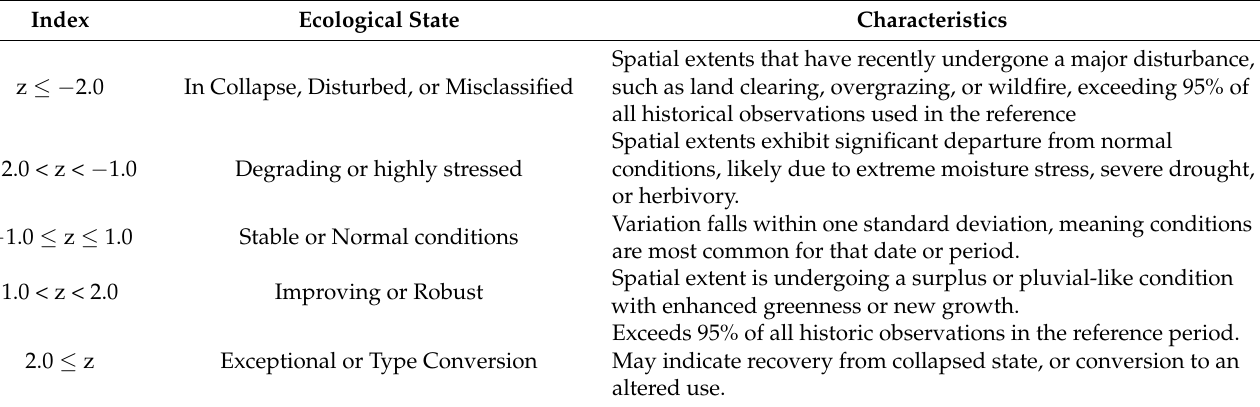
Table 2. Proposed EMSI ranking system for judging ecosystem health based on local standardized scoring. Index Ecological State